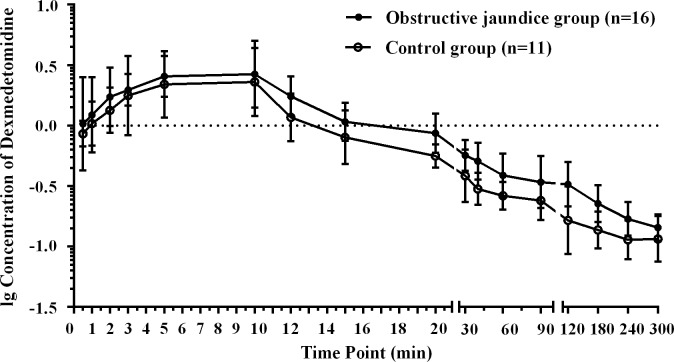
Mean dexmedetomidine plasma concentration on a logarithmic scale versus time data for both groups.Data are expressed as arithmetic means ± standard error (SEM).